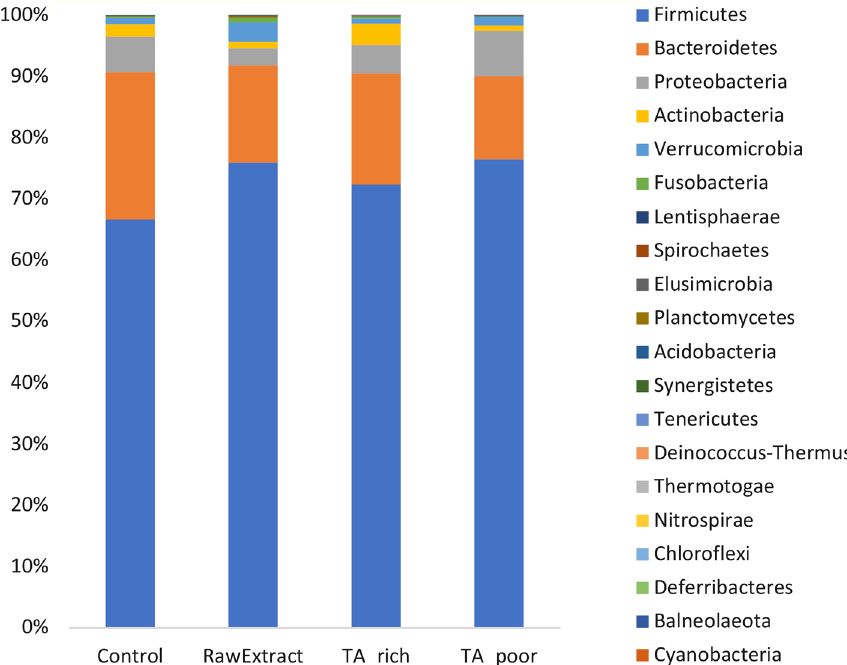
Figure 2. Relative abundances of bacterial phyla in all feeding groups.